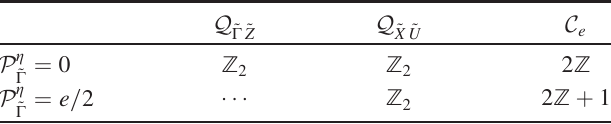
modulo e . The P η ~ ¼ P − ~ Γ Γ